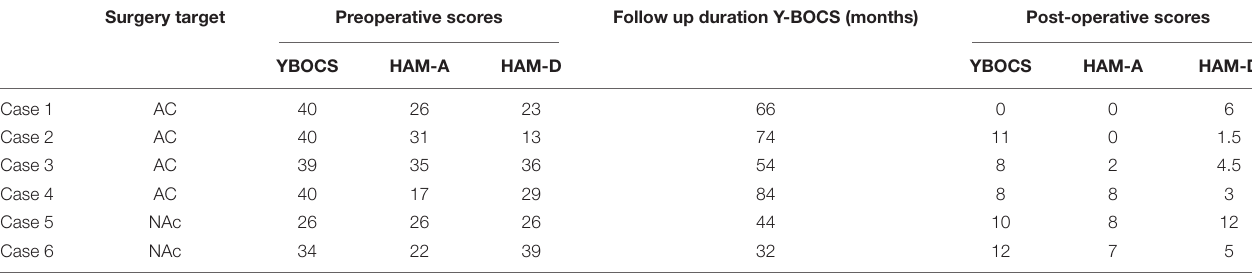
TABLE 3 | Data of patients undergoing anterior capsulotomy or NAc lesioning for OCD. Surgery target Preoperative scores Follow up duration Y-BOCS (months) Post-operative scores YBOCS HAM-A HAM-D YBOCS HAM-A